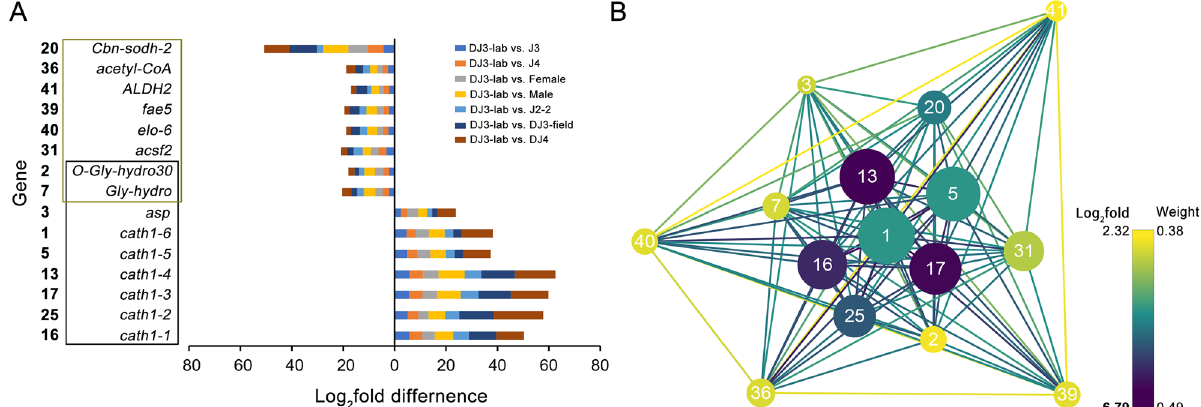
Figure 5. Gene expression difference and network for the 15 lipid metabolism- or autophagy-associated genes selected from the pink module. ( A ) The FPKM differences (normalized by J2) between DJ3-lab and the other PWN stages. Genes in the black box are associated with autophagy, while those in the khaki box are associated with lipid metabolism. ( B ) Gene network for the 15 candidate genes. The size of the dots represents GS (from 0.9361 to 0.9984). Prefuse Force Directed Layout was applied based on the weight value between two genes. The color of the dots represents log 2 fold (from 2.3238 to 6.7868) for the FPKM of DJ3-lab vs. the average FPKM of the other samples. The color of the lines represents the weight value between the two genes (from 0.3770 to 0.4864). The label of dots is listed based on IC (from 108.1303 to